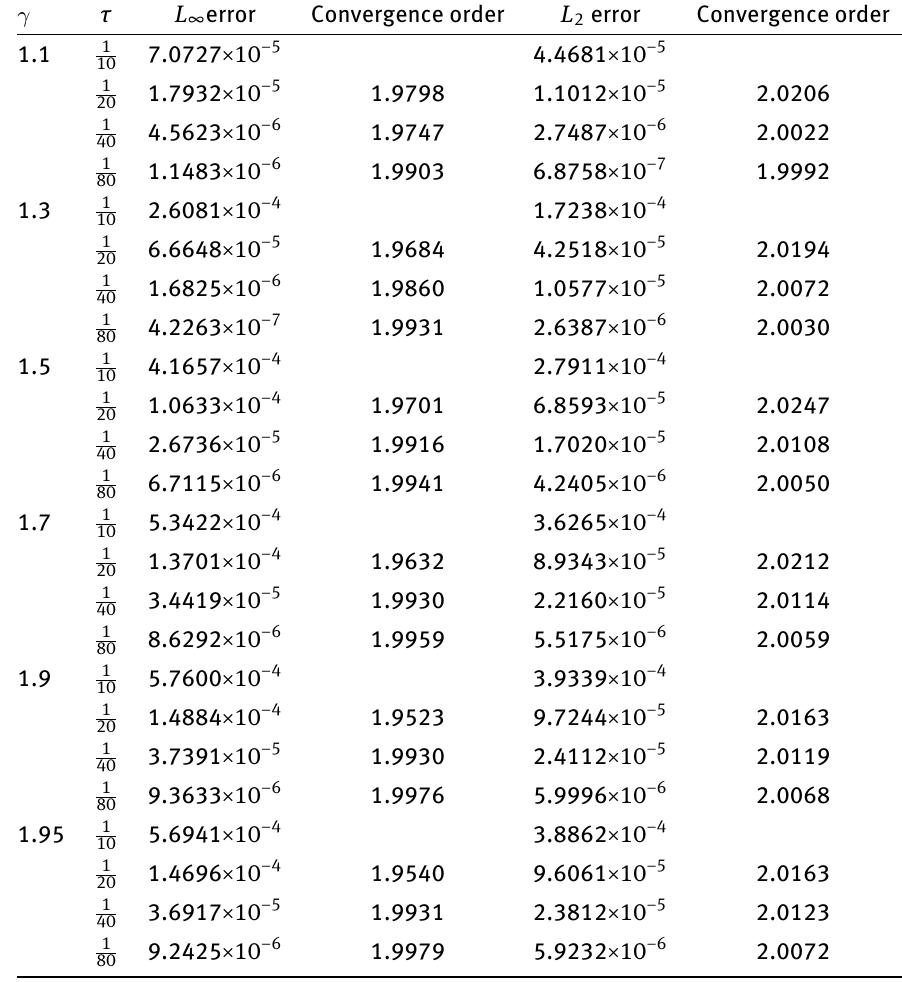
Table 1: The L ∞ , L 2 errors and temporal convergence orders with τ = h for Example 1.